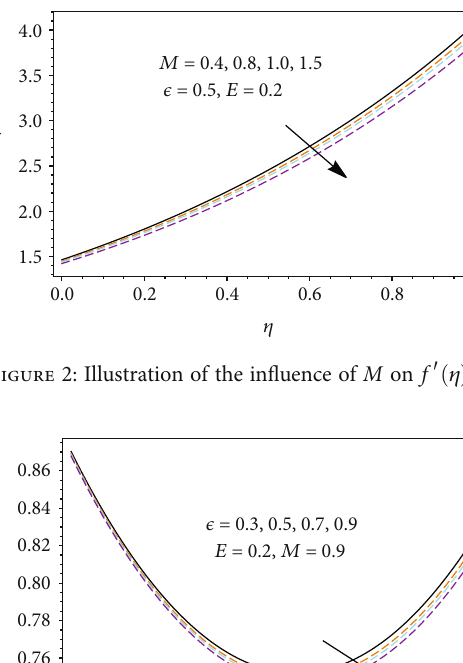
Figure 5: Illustration of the in fl uence of the input factor Q > 0 on θ ð η Þ .